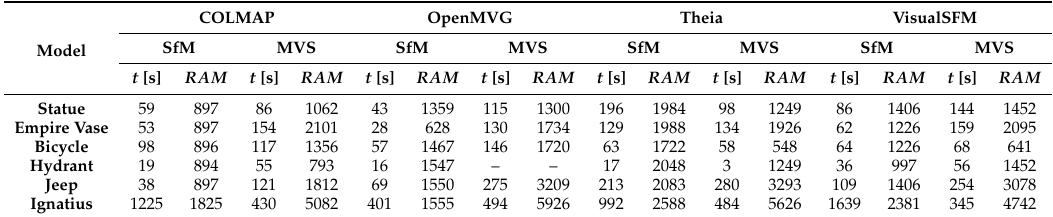
Table 5. Pipelines execution times in seconds and memory usage in